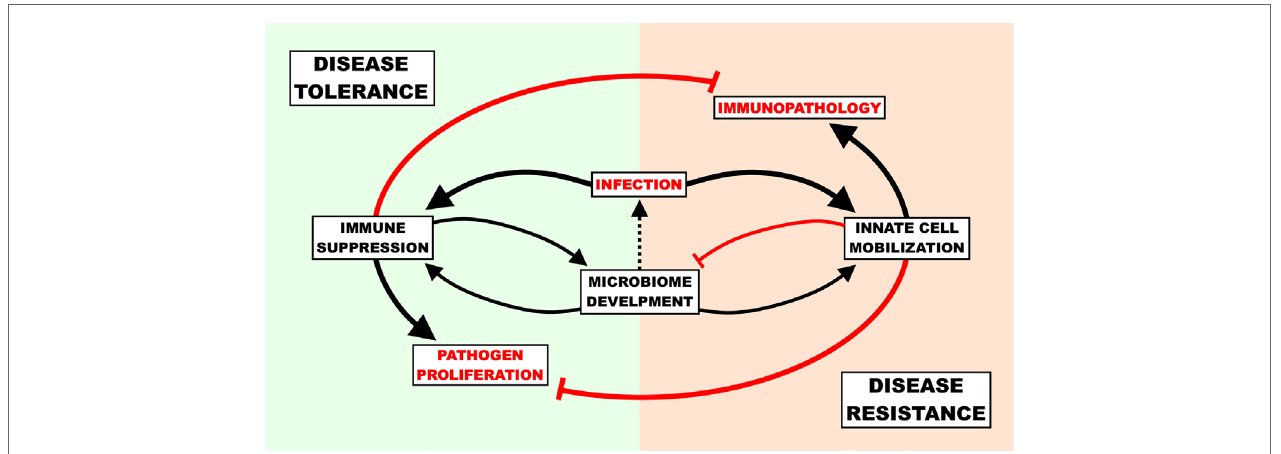
FiGUre 1 | The cost of host-defense strategies in newborn infection. The immune response must be suppressed to a degree in order to allow healthy commensal colonization of the gut, though unchecked suppression can result in gut “leakiness” and lead to infection. Upon infection, newborns must balance the potential self-inflicted harm associated with the pro-inflammatory/antimicrobial response (immunopathology) with the dangers of unencumbered pathogen proliferation and ensuing virulence. A disease tolerance strategy reduces immunopathology and supports microbiome development at the cost of pathogen load, while a disease resistance strategy reduces pathogen load at the cost of microbiome development and immunopathology.